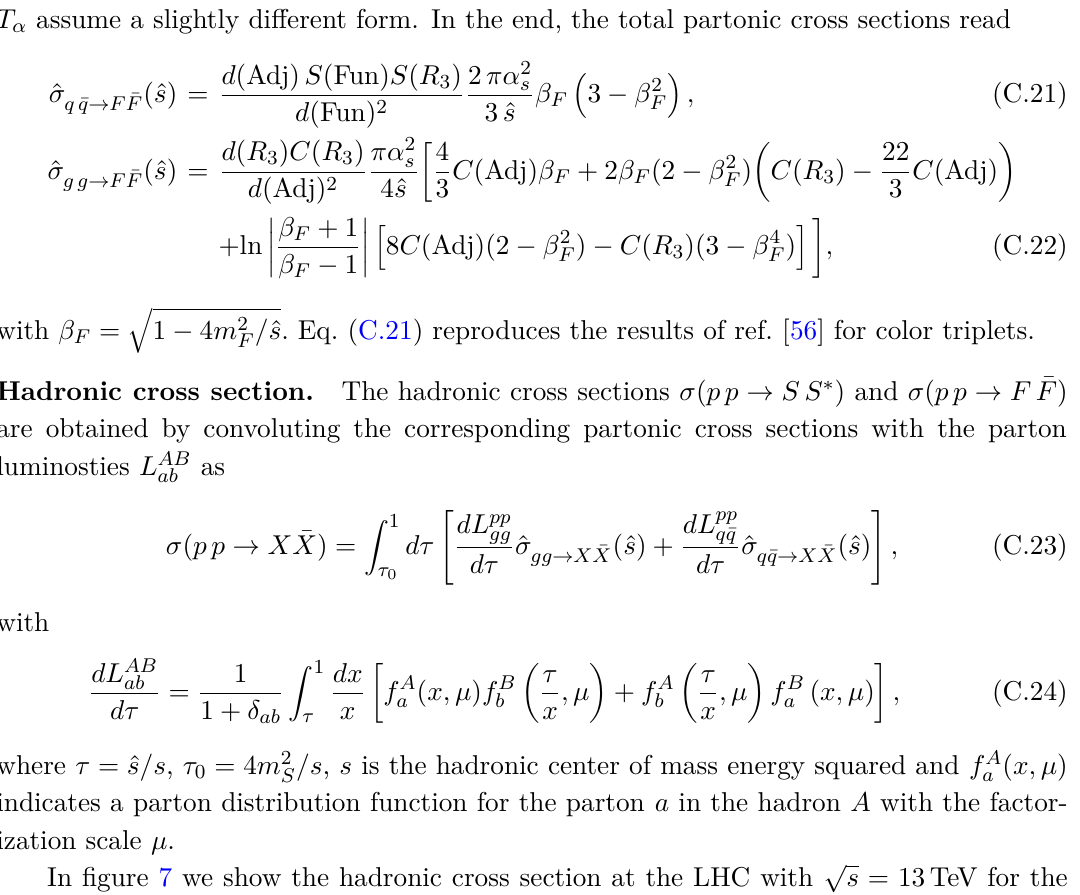
Figure 7 . Contributions to the pair-production cross section at the LHC with SU(3) triplet fermions (left) and scalars (right) as a function of their mass, stemming from the C quark-antiquark annihilation (red dotted) and the gluon fusion (blue